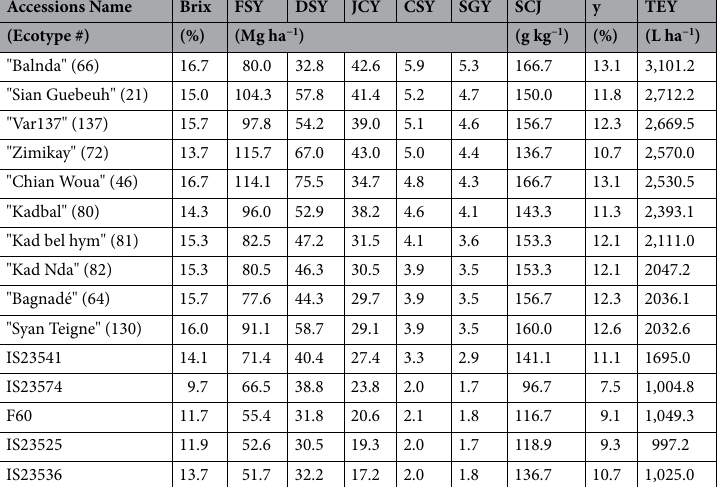
Table 9. Compositional characteristics of 10 promising genotypes of Chadian sweet sorghum compared to ICRISAT checks (IS: 23,541, 23,574, 23,525, 23,536, and F60). FSY: fresh stalk yield; DSY: field dried stalk yield; JY: is a juice yield; CSY: conservative sugar yield; SY: sugar yield; SCJ: sugar concentration of juice; y: total soluble sugar; TEY: theoretical ethanol